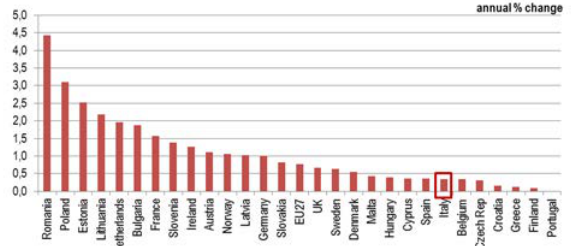
Figure 1. European Energy Efficiency variation 1997-2007 (Mure – Odex